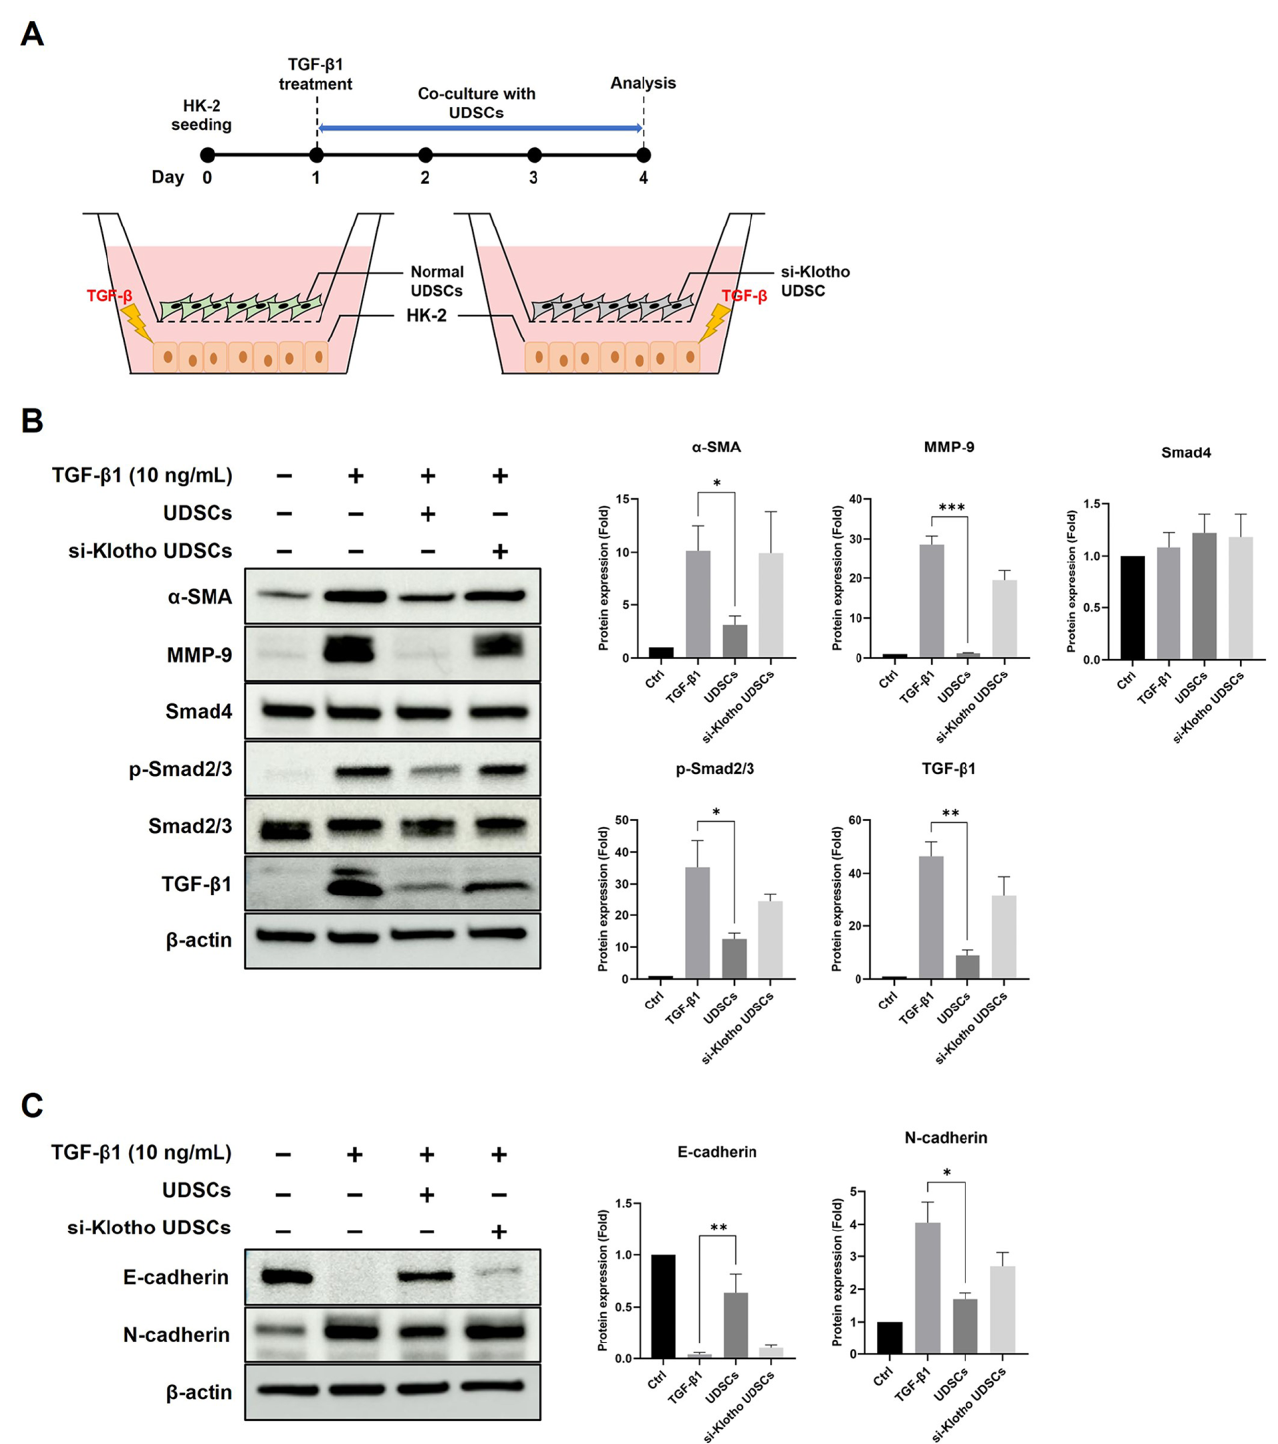
Figure 5. UDSCs suppress fibrosis in HK-2 cells via the TGF- β/Smad signaling pathway. ( A ) The experimental design of an indirect co-culture assay. ( B ) In total, 10 ng/mL TGF- β1 -treated HK-2 were co-cultured with normal UDSCs or si-Klotho UDSCs for 72 h. The TGF- β/Smad signaling pathway was analyzed by Western blotting using HK-2 cell lysates. ( C ) EMT-related proteins were analyzed by Western blotting using HK-2 cell lysates. The results are shown as the mean ± SEM. * p < 0.05, ** p < 0.01, *** p < 0.001 vs. Control.